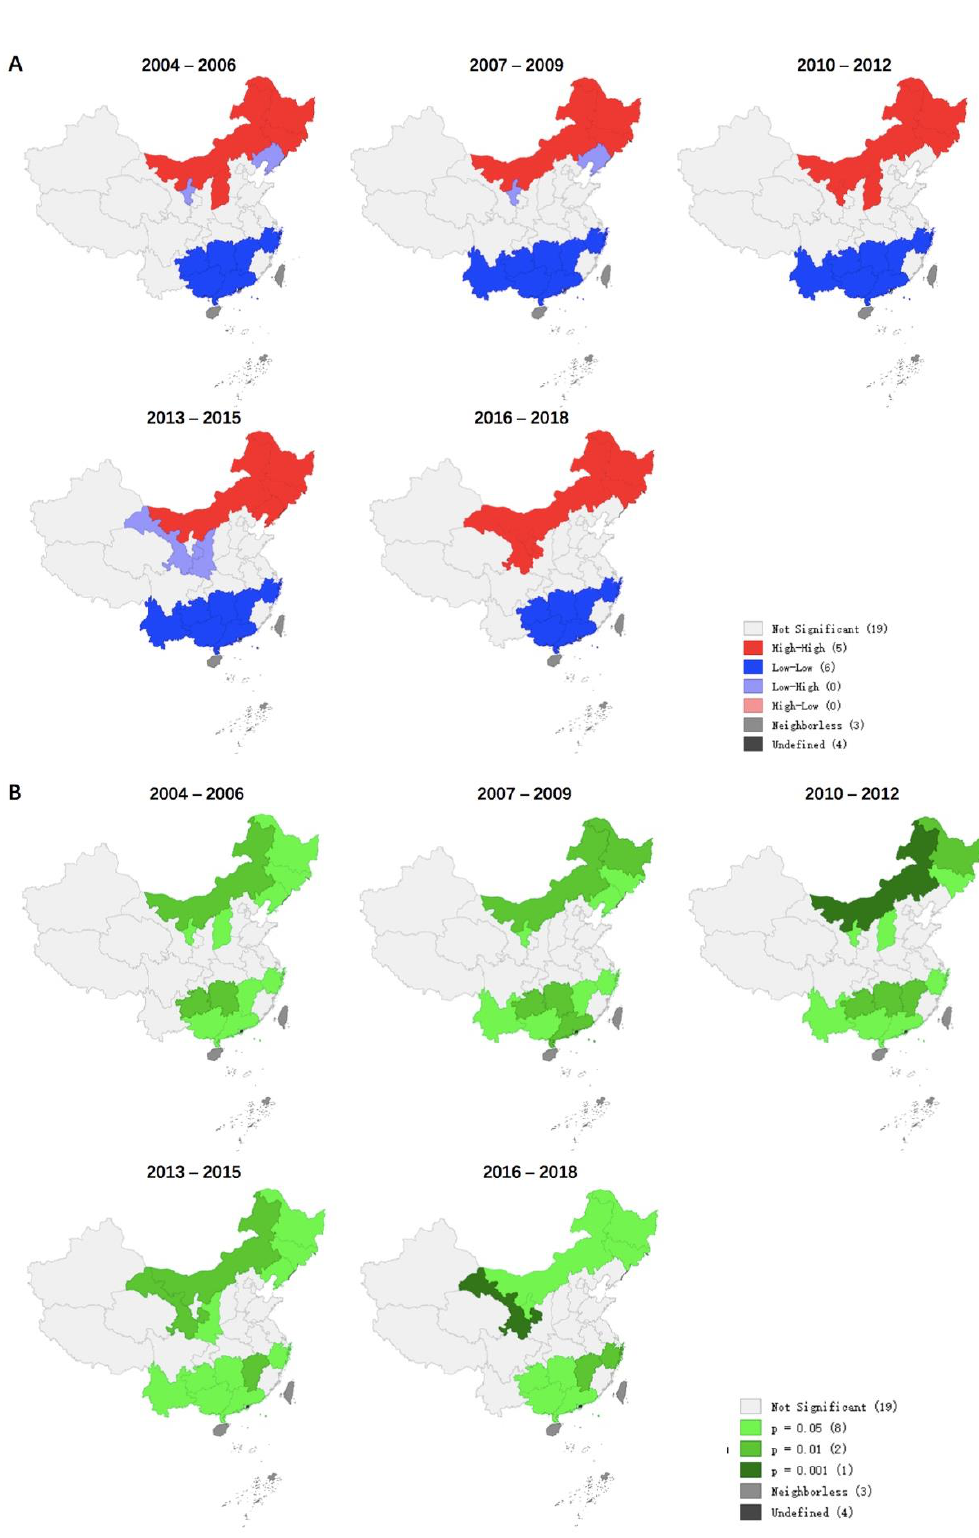
Figure 6. Moran’s I chart of HB incidence rate per 100,000 residents in China from 2004 to 2018 (by 3 year period). ( A ) Local Moran’s I cluster map. ( B ) Local Moran’s I significance map.